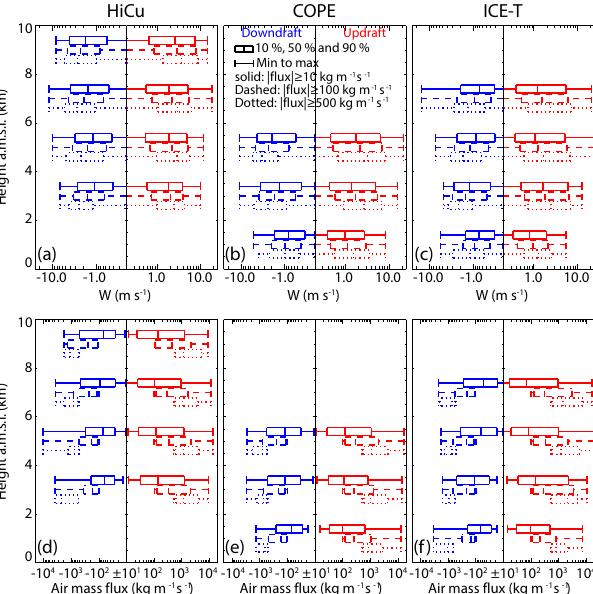
Figure 10. Profiles of (a–c) the vertical velocity and (d–f) air mass flux for all the updrafts and downdrafts sampled at 0–2, 2–4, 4–6, 6–8, and 8–10km. The dotted, dashed, and solid boxes represent the drafts with air mass flux ≥ 10, 100, and 500kgm − 1 s − 1 in magni- tude,